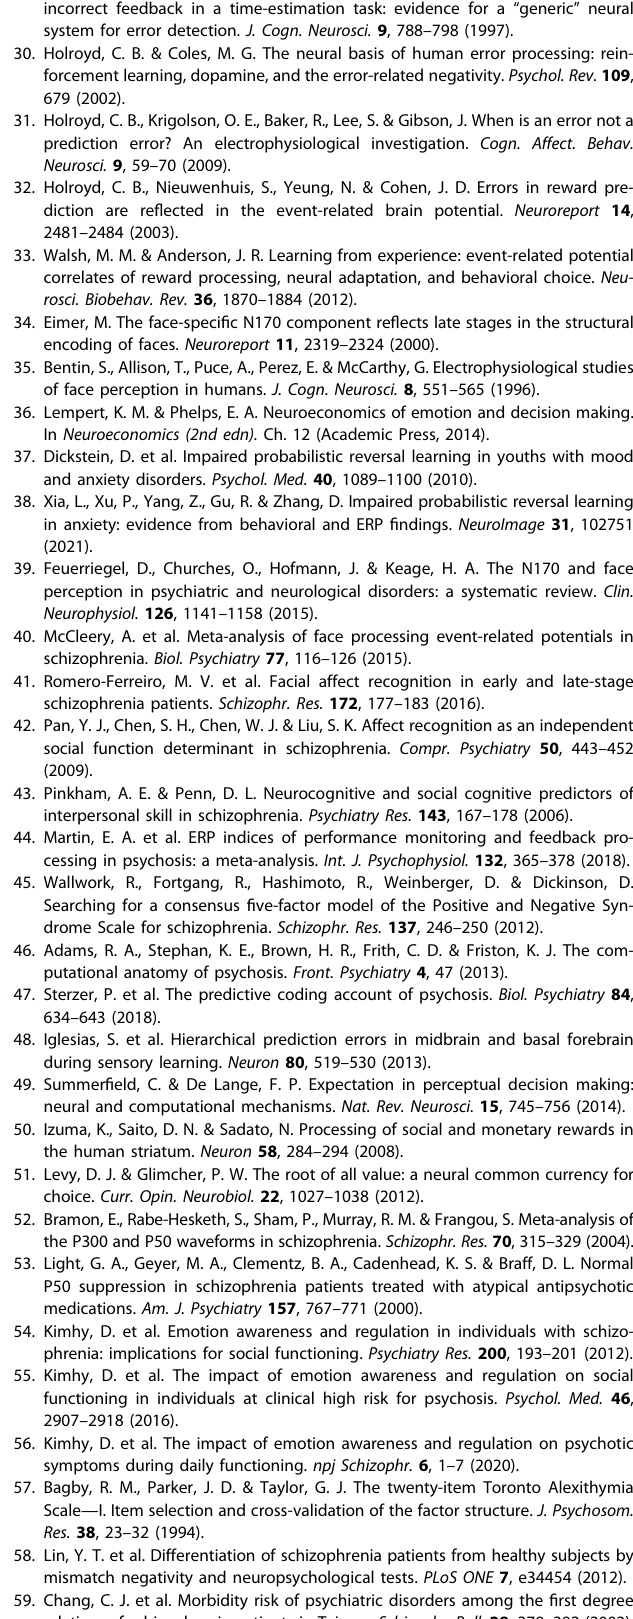
Scale — I. Item selection and cross-validation of the factor structure. J. Psychosom. Res. 38 , 23 – 32 (1994). 58. Lin, Y. T. et al. Differentiation of schizophrenia patients from healthy subjects by mismatch negativity and neuropsychological tests. PLoS ONE 7 , e34454 (2012). 59. Chang, C. J. et al. Morbidity risk of psychiatric disorders among the fi rst degree relatives of schizophrenia patients in Taiwan. Schizophr. Bull . 28 , 379 – 392